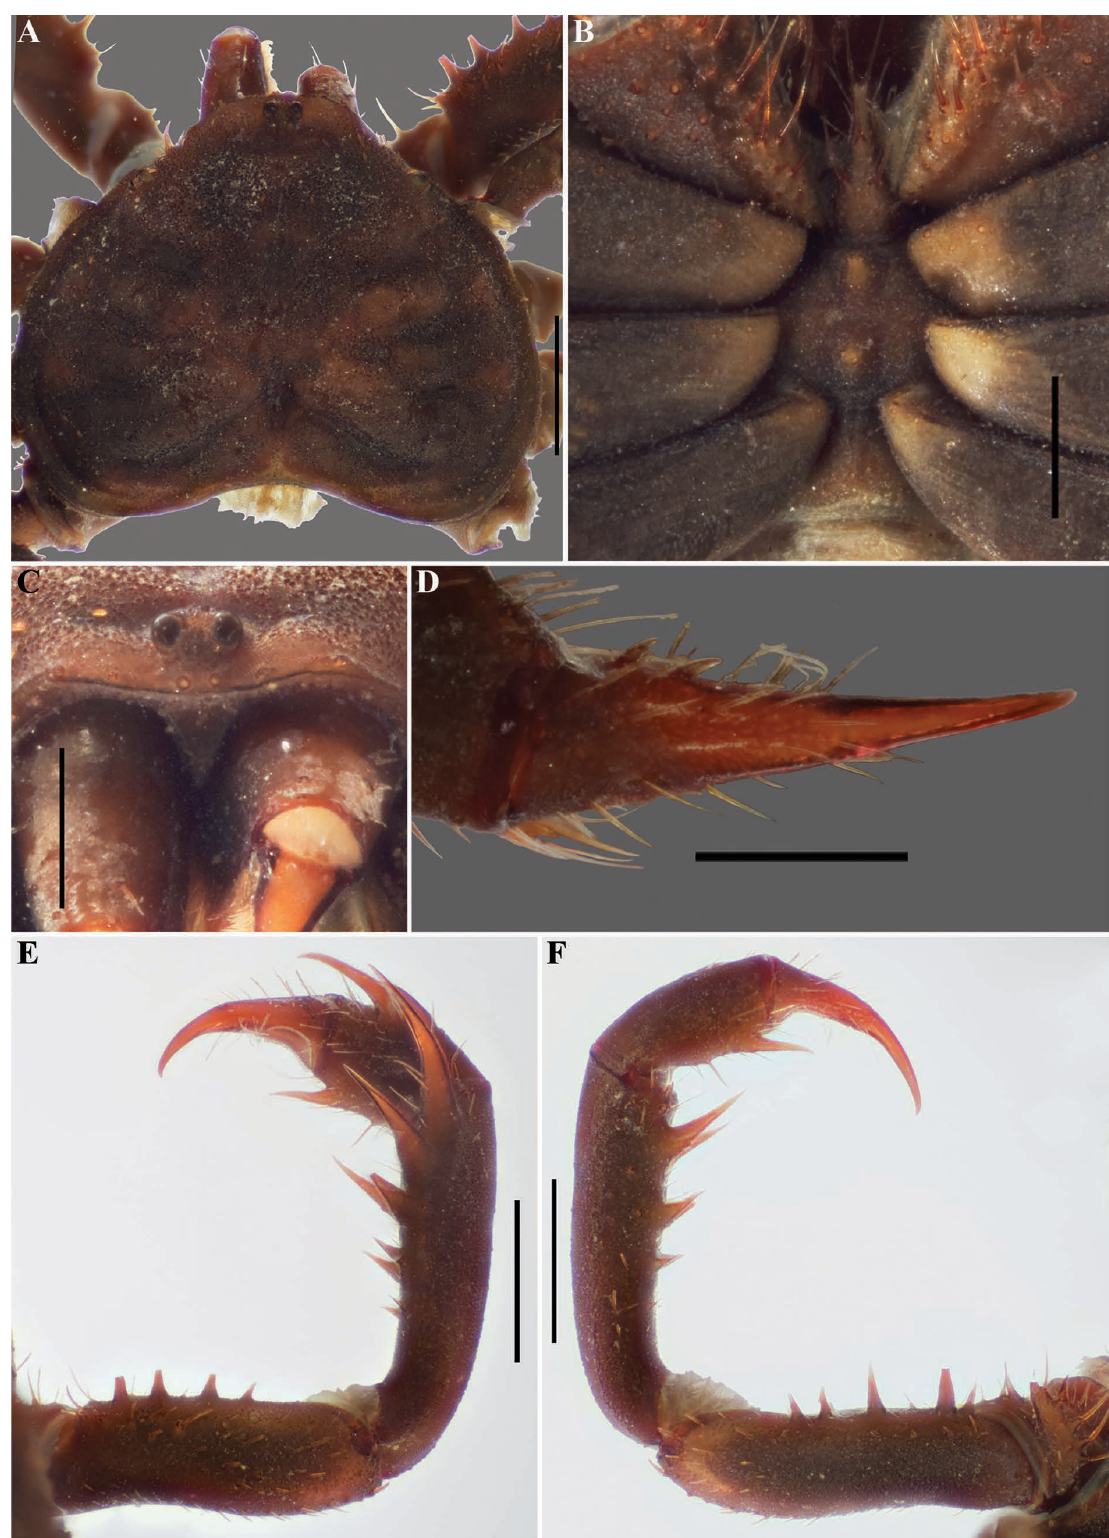
Fig. 122. Sarax rimosus (Simon, 1901) (CUMZ I.48100), general morphology, ♀. A . Carapace, dorsal view. B . Sternum, ventral view. C . Frontal process. D . Pedipalp tarsus, frontal view. E . Pedipalp, dorsal view. F . Pedipalp, ventral view. Scale bars: A, E–F = 1 mm; B–D = 0.5